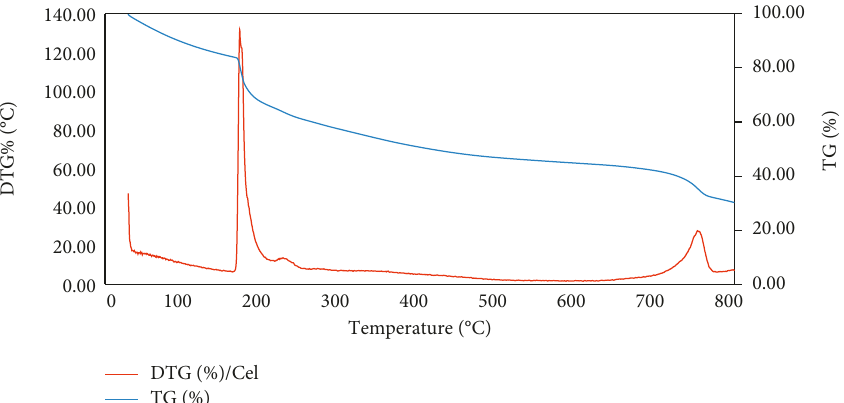
Figure 6: TGA curve and DTG curve for Gracilaria fisheri sample under N